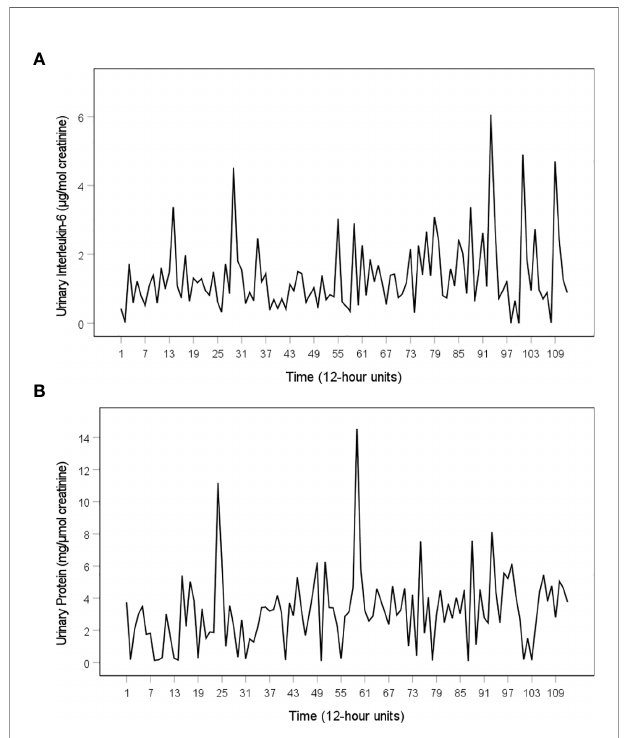
FIGURE 1 | Time series of urinary IL-6 levels and urinary protein levels of the SLE patient under study. (A) Time series of urinary IL-6 (µg per mol creatinine), (B) Time series of urinary protein ( m g per mol creatinine). Both time series cover a period of 56 days. During this time, the patient collected her full urine output in 12 h intervals, resulting in a total of 112 12 h measurements. The 112 12 h units consist of daytime intervals (from 8:00 a.m. to 8:00 p.m., uneven numbers) and nighttime intervals (from 8:00 p.m. to 8:00 a.m., even